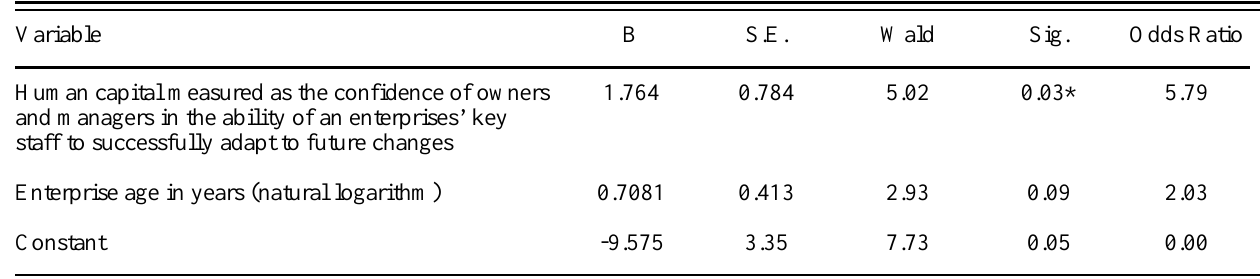
Table 7. Regression model for enterprises that do not exit under a 50% systemic shock scenario (Corrected Akaike’s Information Criterion score = 49.31).